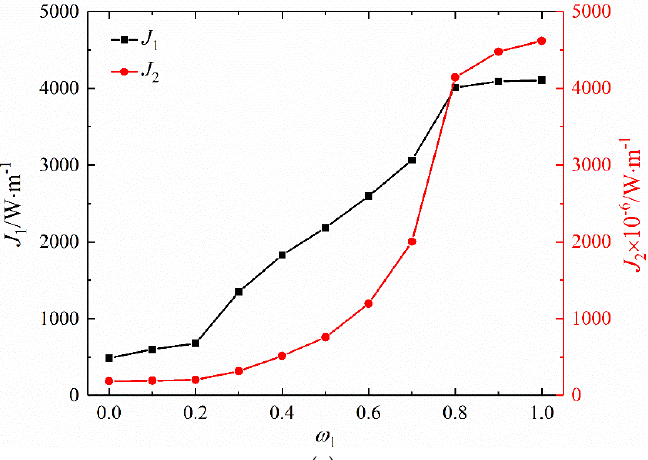
Figure 7. Optimal solutions, Pareto frontier, and corresponding optimal topology configurations under different ω 1 values.